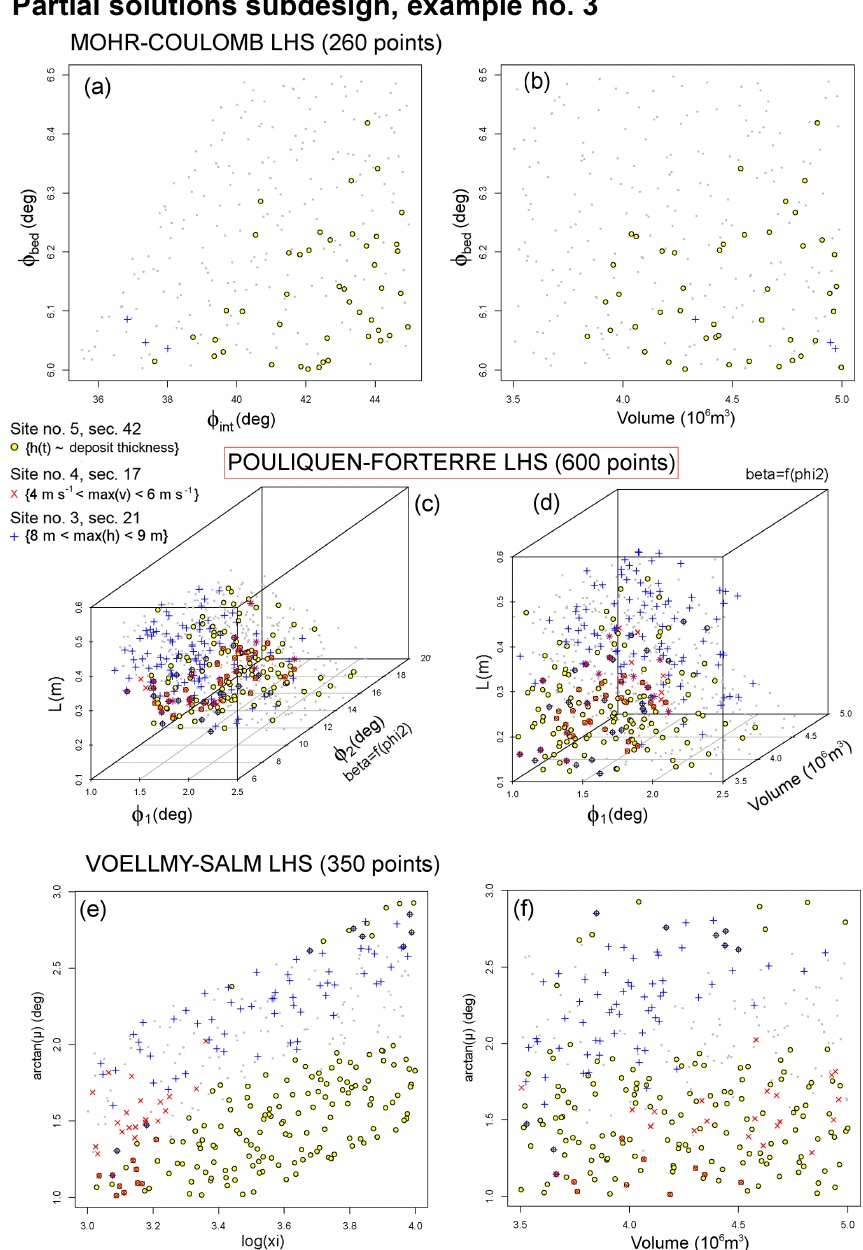
Figure 16. Example 3 of partial solution inputs in the (a, b) MC, (c, d) PF, and (e, f) VS experimental designs. Panels (a, c, e) are projected along the V coordinate, and (b, d, f) are projected along φ int , φ 2 , and ξ coordinates. The color expresses the considered data: yellow is deposit thickness at Site 5 (Saucedo et al., 2008), blue is wave height at Site 3 (Ponce-Segura, 1983), and red is peak flow speed at Site 4 (Pierson,